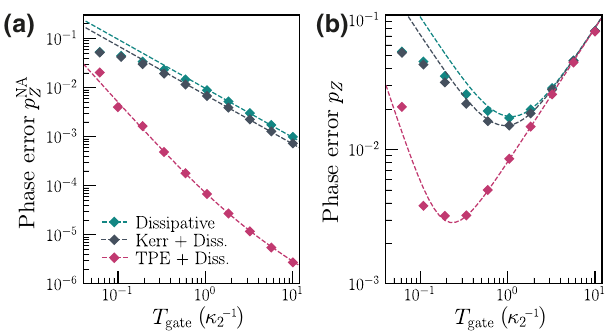
FIG. 9. (a) Gate-induced phase errors for a Z gate at | α | 2 = 8 for a combined TPE and two-photon dissipation confinement, at varying confinement ratios of g 2 /κ 2 . Diamonds indicate a con- stant gate Hamiltonian drive, while circles indicate a Gaussian- type gate Hamiltonian drive with first-order superadiabatic cor- rection, as in Ref. [28]. Lines indicate the analytical fit Eq. (11) in the constant drive regime. Gate times are in units of 1 /κ 2 . (b) Total bit-flip errors for a Z gate under the same confinement schemes, with single-photon loss at rate κ 1 = 10 − 3 κ 2 , thermal noise n th = 10 − 2 , and pure dephasing κ φ = 10 − 5 κ 2 . Markers indicate numerical data, and dotted lines indicate exponential fits for 2 ≤ | α | 2 ≤ 12; the corresponding exponential suppression factors are the values γ represented on Fig.